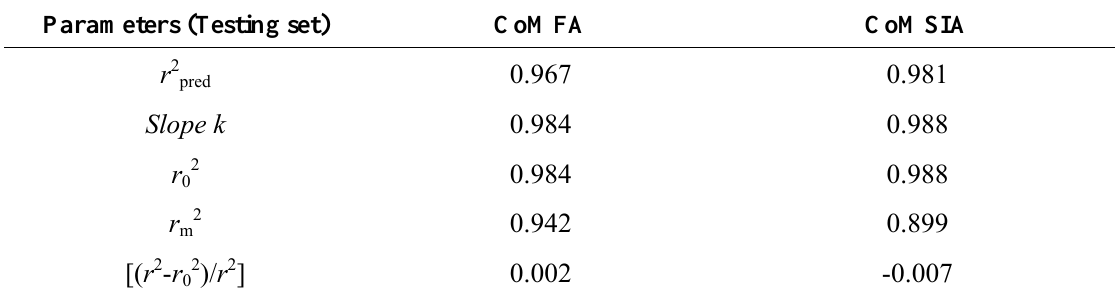
Table 4. Statistical parameters of the external